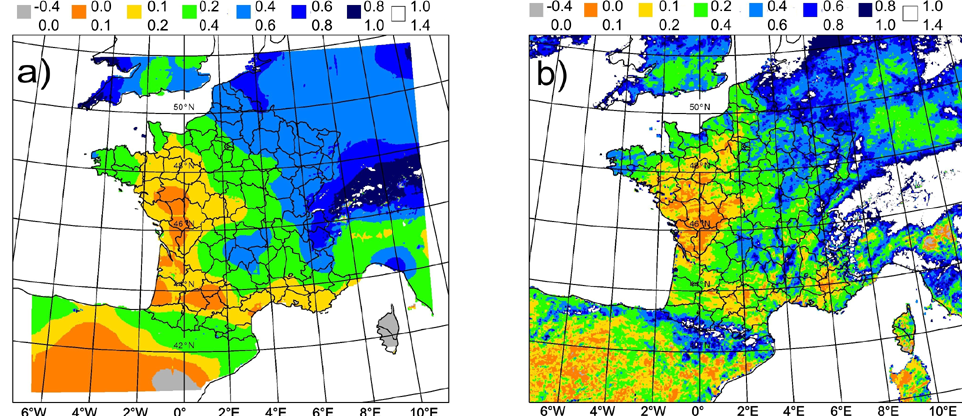
Fig. 8. Soil wetness index (negative values are associated with very dry soils; values larger than one indicate moist soils evaporating at maximum rate) on 1 October 2010. (a) Operational AROME suite (soil moisture field interpolated from the one produced for the global- scale model ARPEGE). (b) Experimental AROME suite (having its own surface analysis